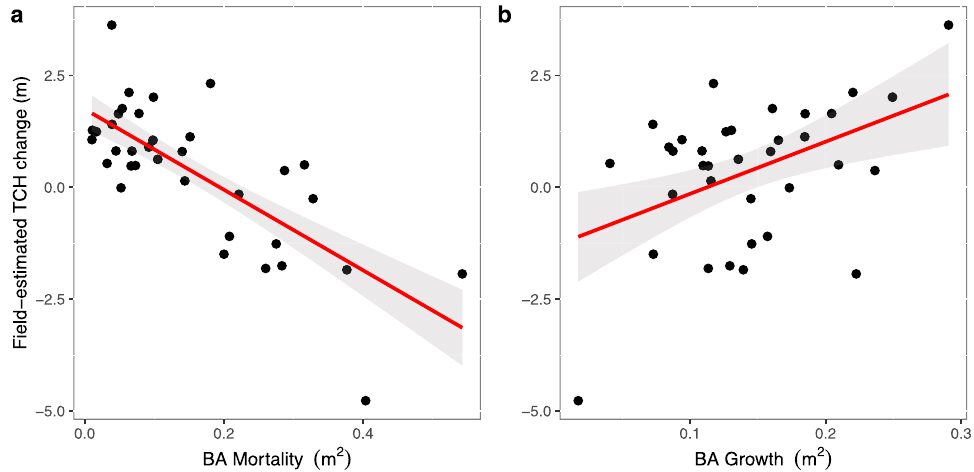
Fig. 4 Correlation between canopy height and forest plot dynamics rates. The effects of a basal area (BA) loss arising from stem mortality and b basal area growth on the fi eld-estimated top-of-canopy height from 38 permanent forest inventory plots (SAFE plots, each 25 × 25 m in size). Black dots represent the permanent plots (and missing plots are due to the presence of clouds during the fi rst and/or second fl ights). The red lines represent predicted values from multiple linear regression (i.e. fi eld-estimated TCH change = β 0 + β 1 BA mortality + β 2 BA growth) with 95% con fi dence intervals shown in